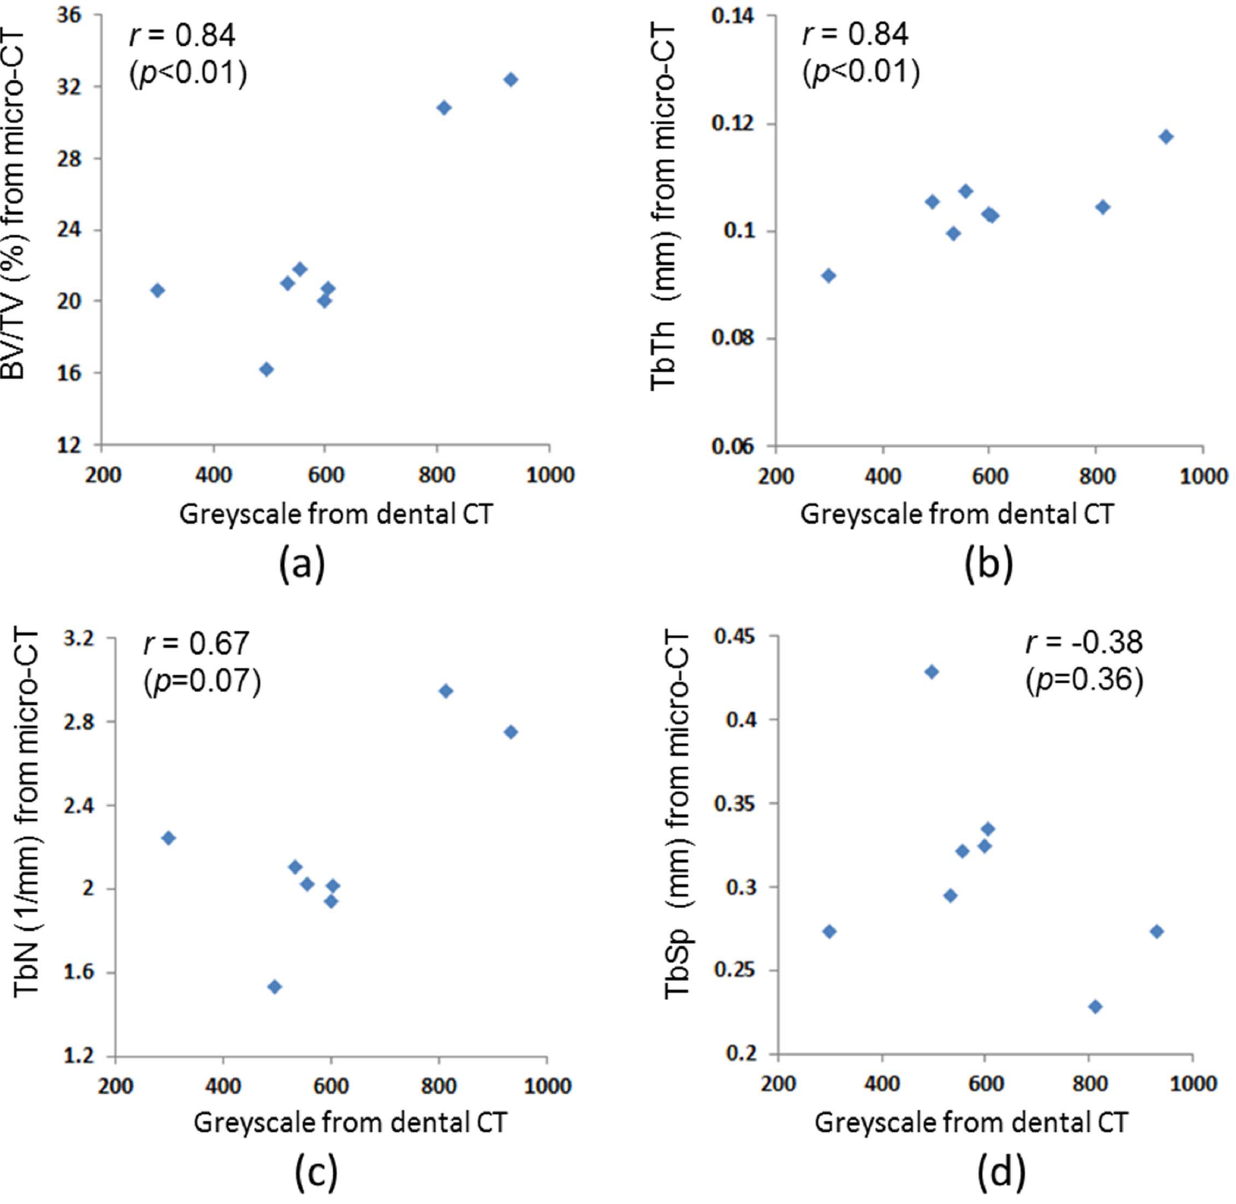
Figure 3. Correlations of the vCanGrayscale (grayscale value of the cancellous bone of 5 th vertebral body) measured using dental CT and micro-CT with BV/TV (a), (b) TbTh, (c) TbN, (d) TbSp.